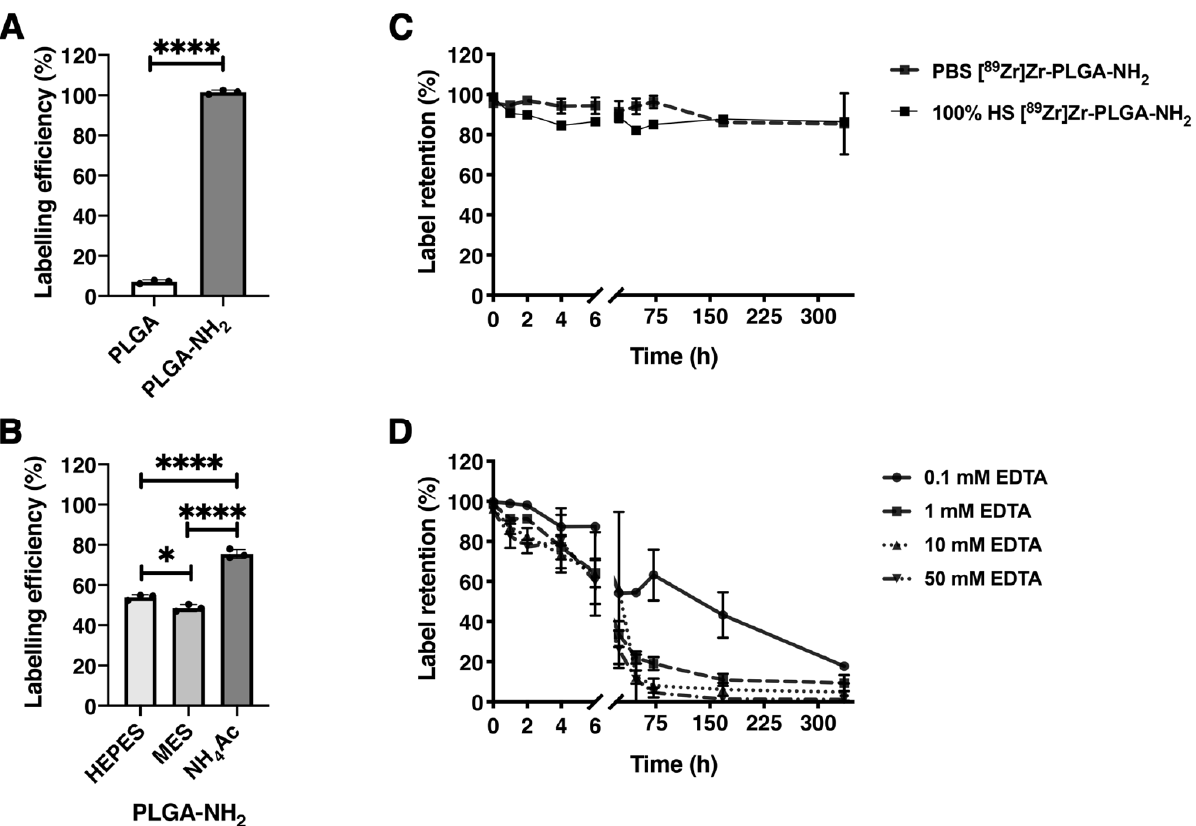
Figure 1. 89 Zr-labeling of NPs and label retention. ( A ) Labeling efficiency of PLGA and PLGA-NH 2 NPs with [ 89 Zr]ZrCl 4 ( n = 3). ( B ) 89 Zr-labeling of PLGA-NH 2 NPs in 0.5 M and pH 5.5 HEPES, MES and NH 4 Ac labeling buffers ( n = 3). ( C ) 89 Zr-retention by PLGA-NH 2 NPs was examined in PBS and 100% human serum (100% HS) at 37 °C at 0, 1, 2, 4, 6, 24, 48, 72, 168 and 336 h ( n = 3). ( D ) EDTA concentration range challenge was performed at 37 °C at 0, 1, 2, 4, 6, 24, 48, 72, 168 and 336 h ( n = 3). * p = 0.0276, **** p < 0.0001.